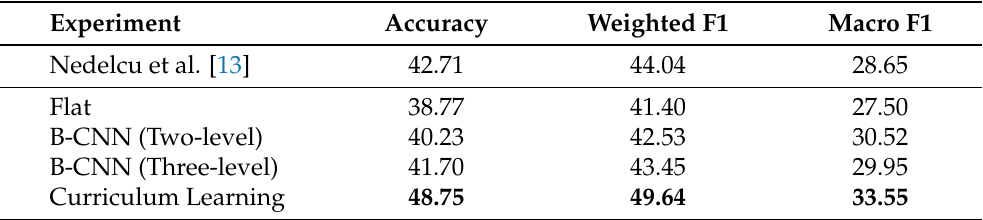
Table 5. Metrics score of test set 1 for differential diagnosis approaches using cropped images with 30% tolerance (in %).